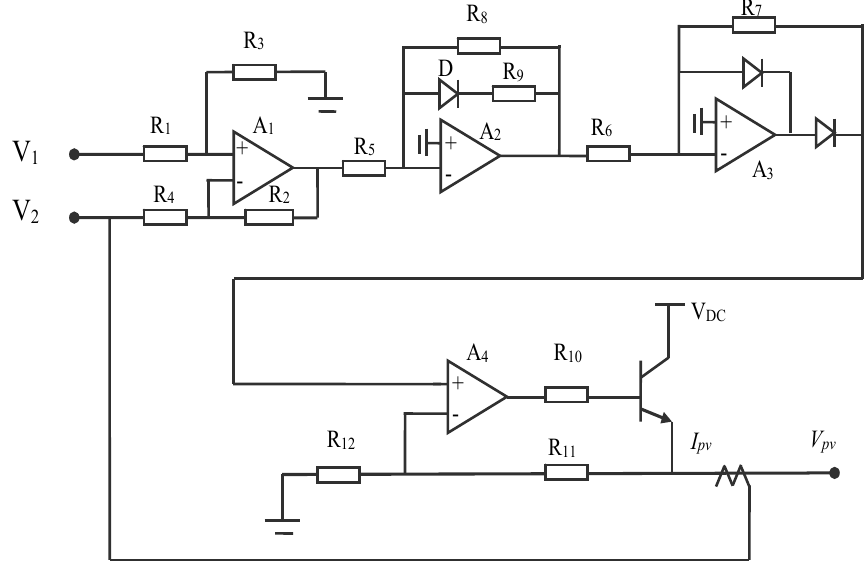
Figure 6. Simplified circuit diagram of the OP-amplifier based PV simulator [13].